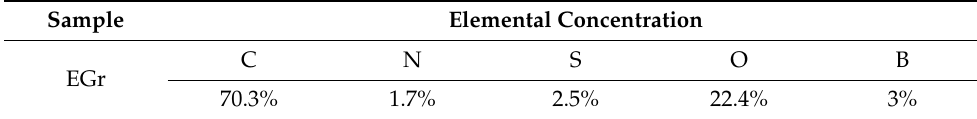
Table 2. Elemental concentrations of C, N, S, O, and B in the EGr sample .